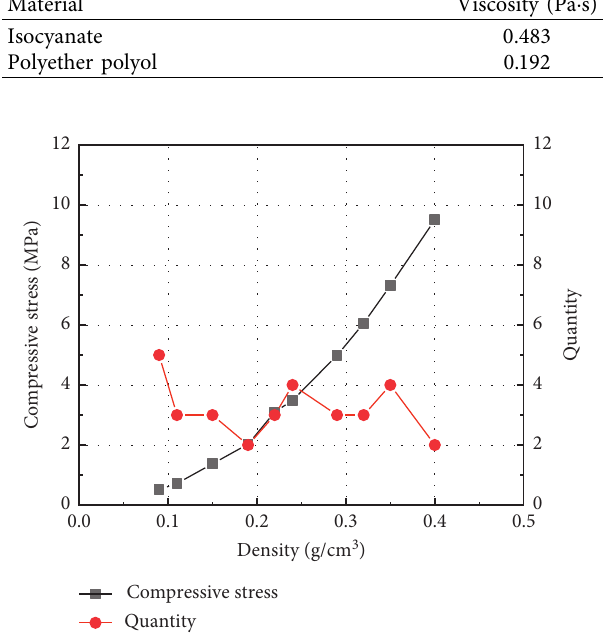
Figure 6: Compressive strength of different densities.